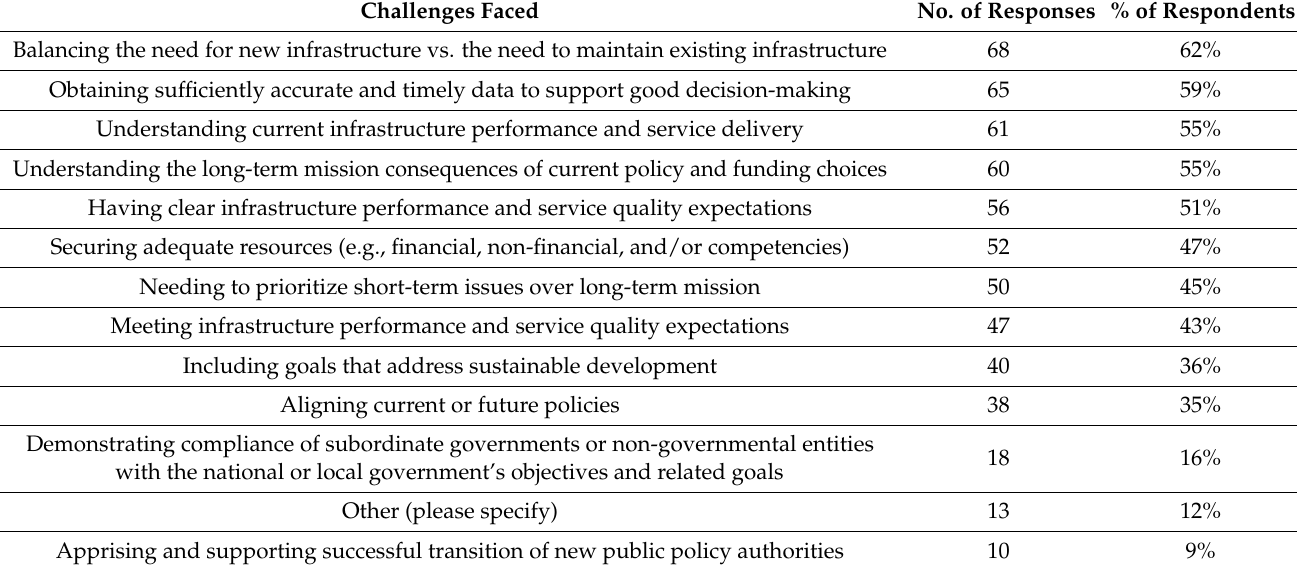
Table 4 identifies the top challenges identified. Table 4. Top challenges related to the delivery of public